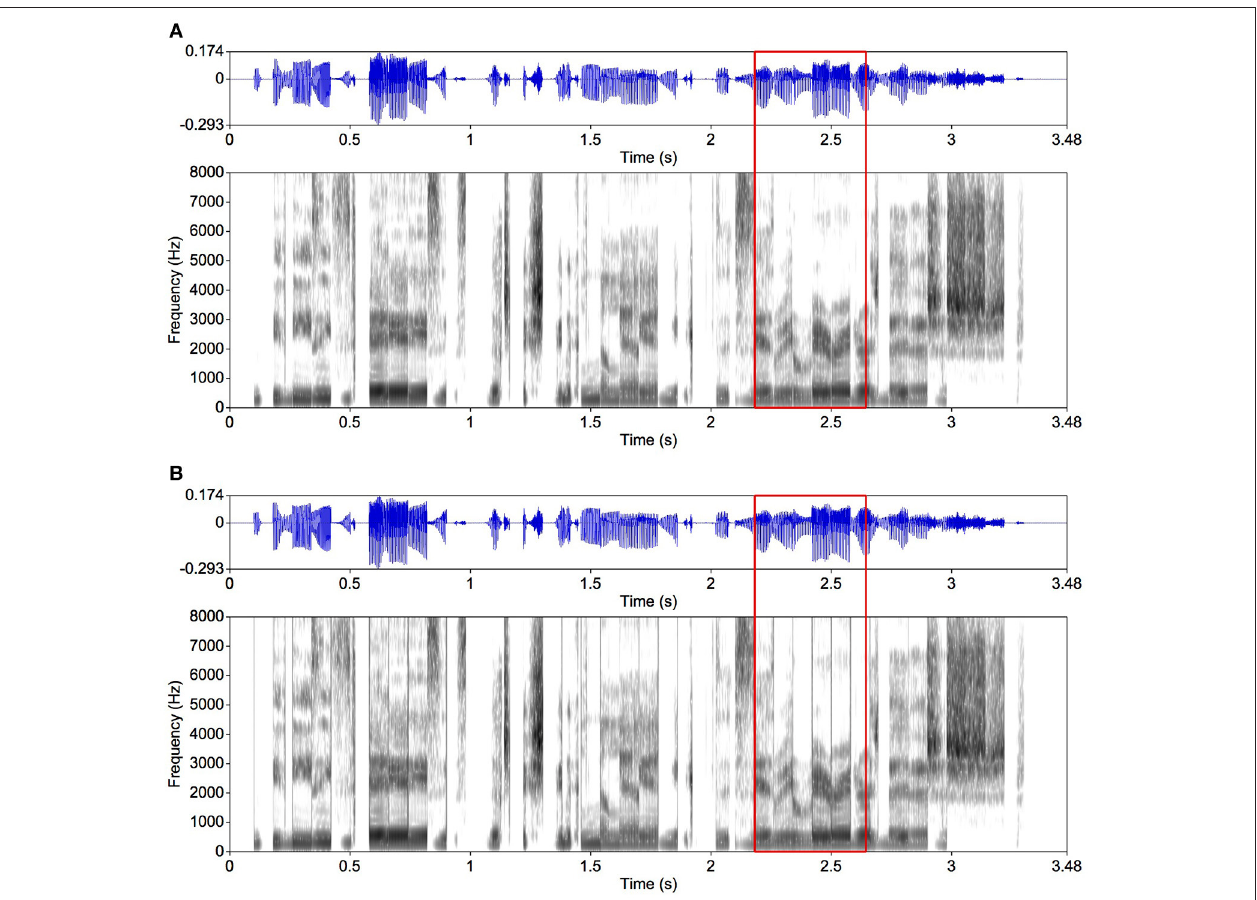
FIGURE 4 | Examples of locally time-reversed speech. The same original speech as in Figure 2 was used. The segment duration was 80 ms. (A) Each segment is smoothed with 5-ms rise and fall times; (B) another version without smoothing. When focusing on the area in the red frames, vertical gray lines in the spectrogram are observed in (B) showing spectral splatters caused by the abrupt onsets and offsets. Such vertical lines are not observed in the spectrogram in (A) where the segments are